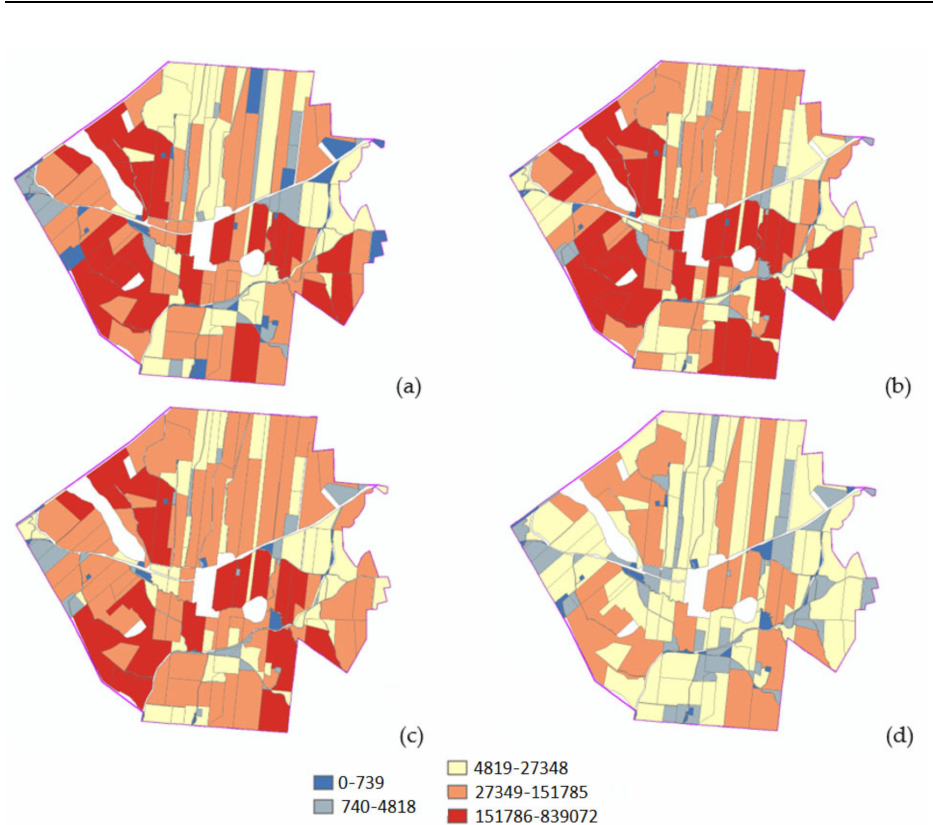
Figure 10. Visualisation of the sum of the total LS factors values in agriculture plots based on SRTM ( a ), DTED2 ( b ), LPIS ( c ) and ISOK ( d ) of the Bolcie research